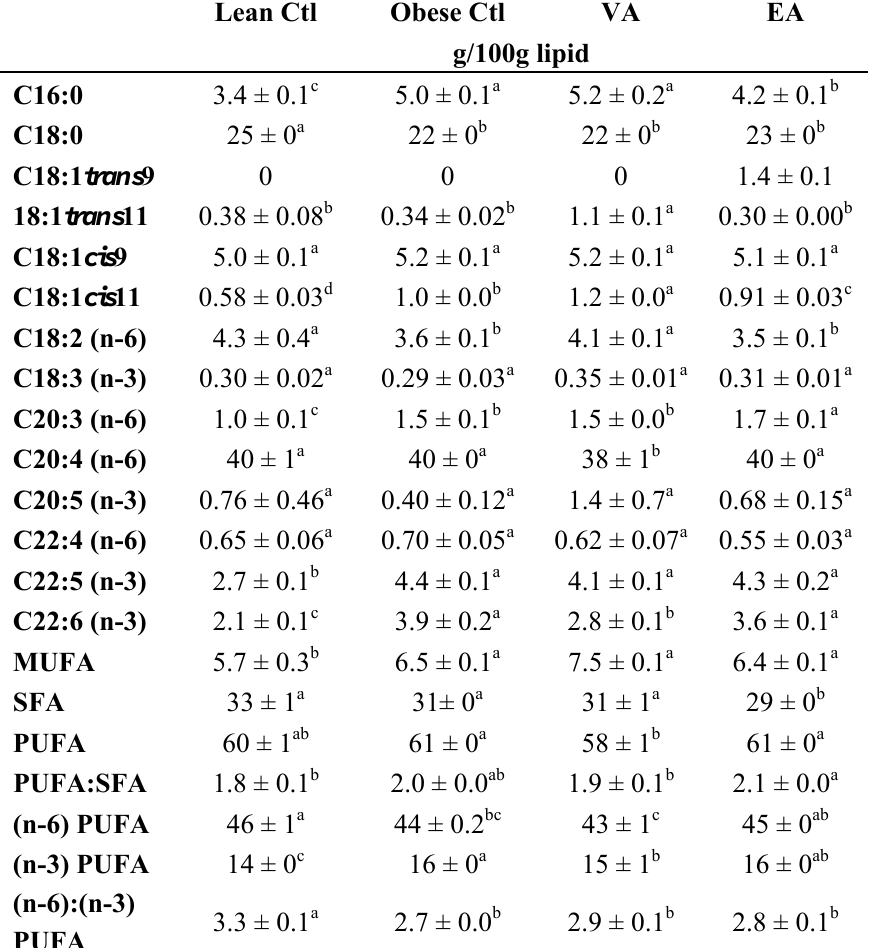
Table 2. Splenocyte phosphatidylethanolamine fatty acid composition of lean rats and obese JCR:LA- cp rats fed Ctl, VA or EA diets.